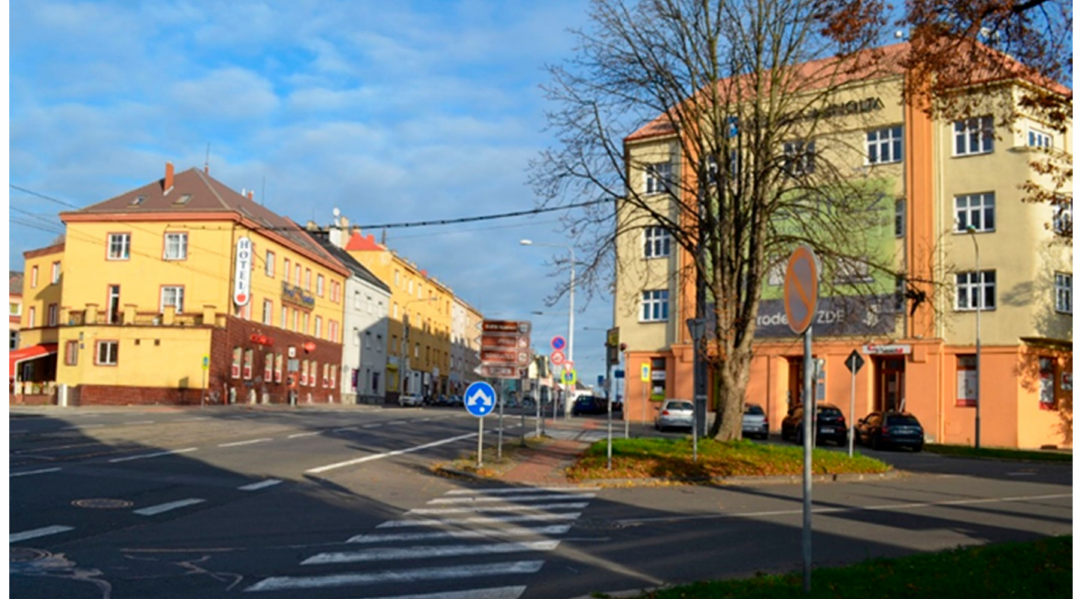
Figure 8. Hub F: a typical urban structure surrounding the hub, location F1. Hub H is the smallest identified hub with approximately 150 employees. Several small- to medium-sized ICT firms reside here. It is located at the northeastern edge of the most populated city district, Ostrava-Jih. The urban structure is formed by